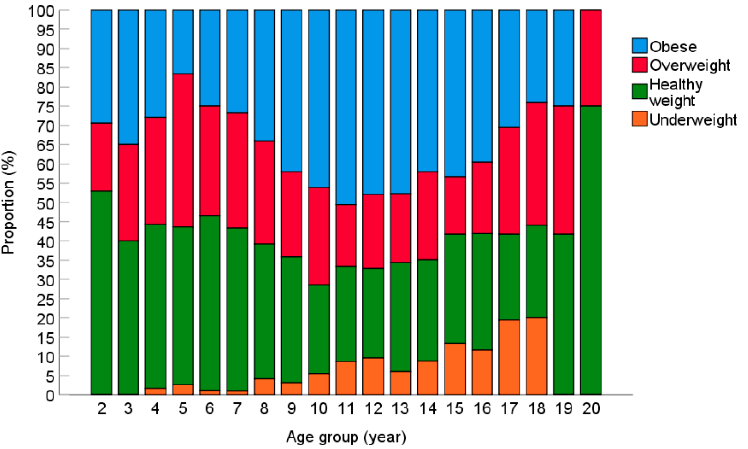
Figure 2. BMI Status Across Age Groups. Sample sizes for age groups: 2 ( n = 17); 3 ( n = 40), 4 ( n = 61), 5 ( n = 78), 6 ( n = 88), 7 ( n = 97), 8 ( n = 97), 9 ( n = 95), 10 ( n = 91), 11 ( n = 81), 12 ( n = 73), 13 ( n = 67), 14 ( n = 57), 15 ( n = 60), 16 ( n = 43), 17 ( n = 36), 18 ( n = 25), 19 ( n = 12), 20 ( n = 4).